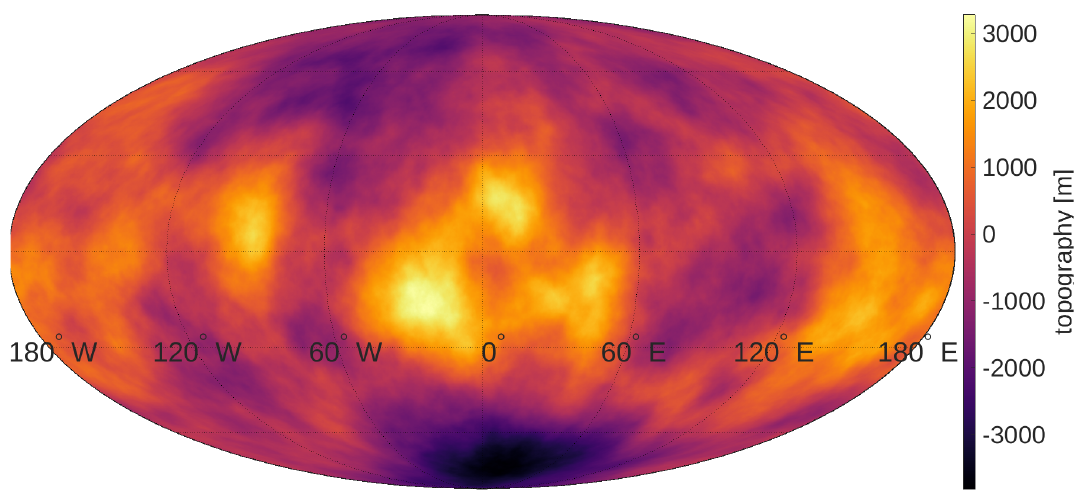
Figure 2. Synthetic Ganymede topography with 1/8 × 1/8 degree resolution based on a power law (Equation (10)) with σ 2 n = 4.6 × 10 6 m 2 n − 3